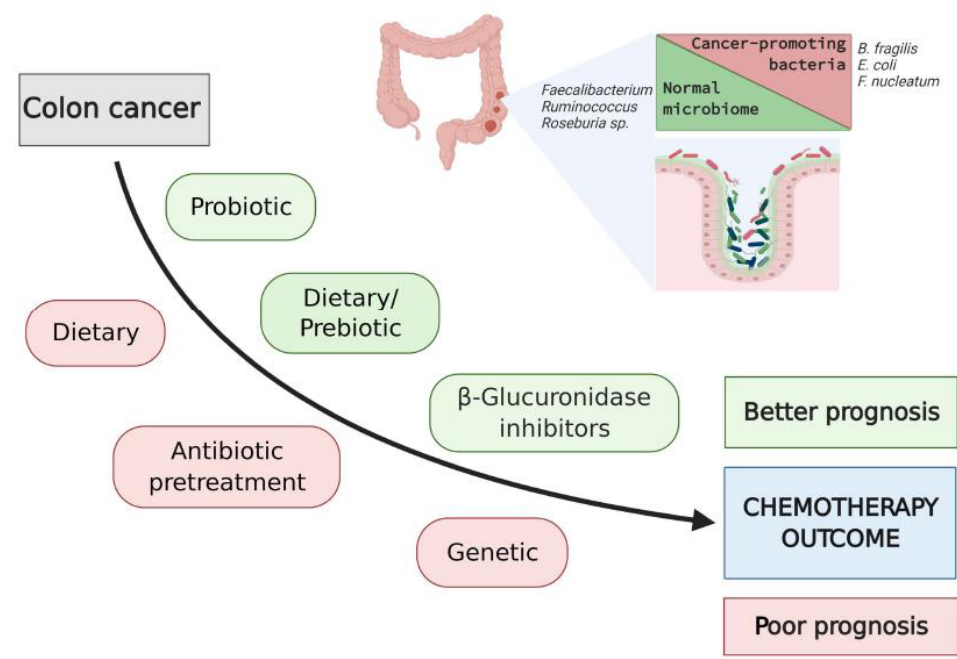
Figure 2. A schematic to illustrate approaches to modify intestinal microbiota and improve clinical outcomes of chemotherapy in patients with colon cancer.